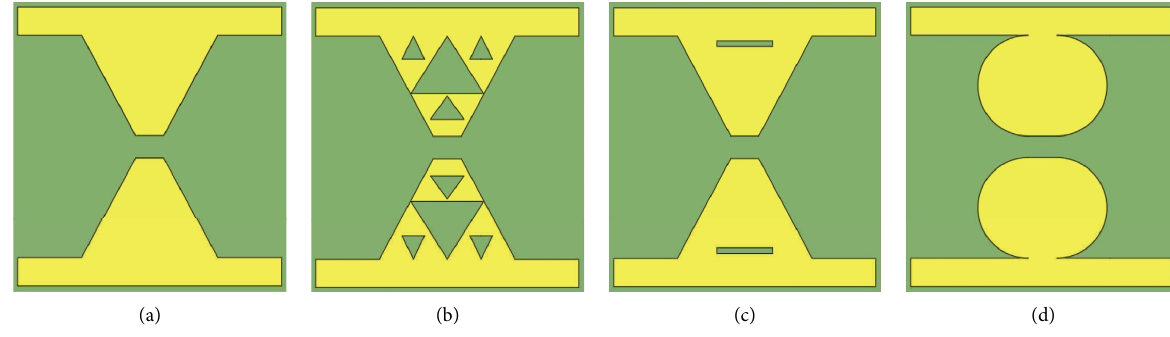
Figure 3: (a) Bowtie, (b) fractal, (c) slotted, and (d) circular PCAs.